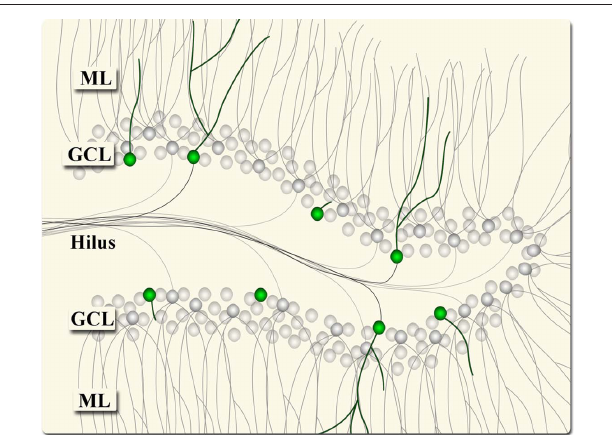
dendrites extended into the molecular layer (ML), and axons extended into the hilus (toward CA3). The green cells represent immature, DCX-positive adult-born